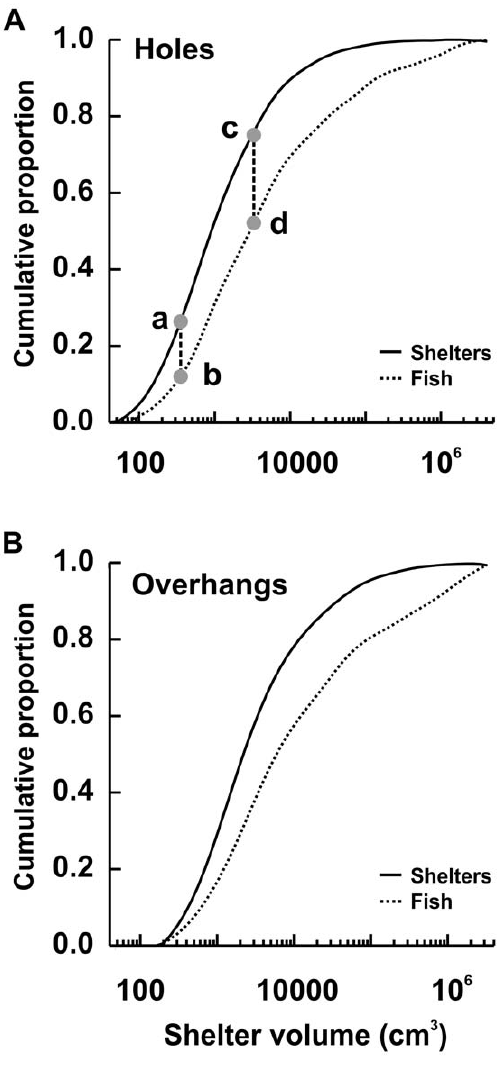
Figure 3. Cumulative proportion of shelters and shelter-using fishes in relation to shelter volume. The cumulative proportion of shelters with minimum entrance diameter . 3 cm (solid lines) and the cumulative proportion of shelter-occupying fishes (dotted lines) in relation to log 10 shelter volume for (A) holes (N=2,134) and (B) overhangs (N=729). The grey dot (labelled ‘‘a’’) indicates the smallest 25% of shelters and corresponds to only 12% of the shelter-dwelling fishes in holes (labelled ‘‘b’’). The largest 25% of shelters (above point ‘‘c’’) correspond to approximately 50% of the shelter-dwelling fishes in holes (above point